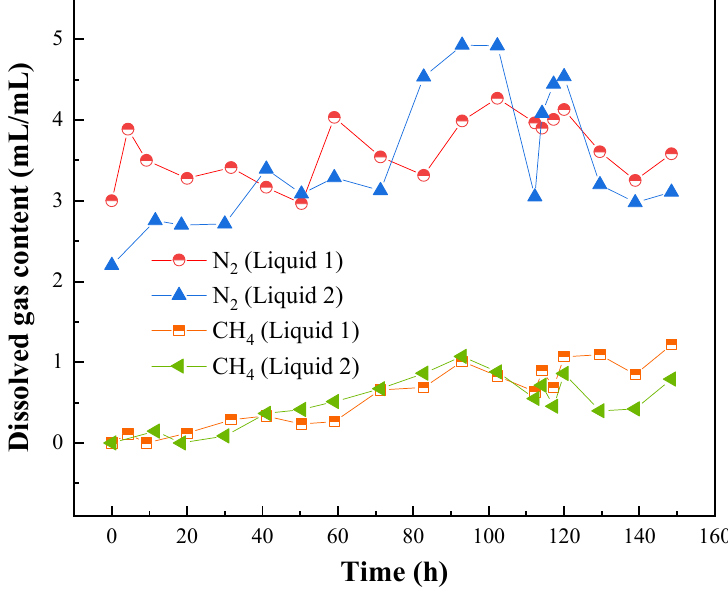
Figure 15. Dissolved gas content change in unit water in the upper and lower liquid phases.